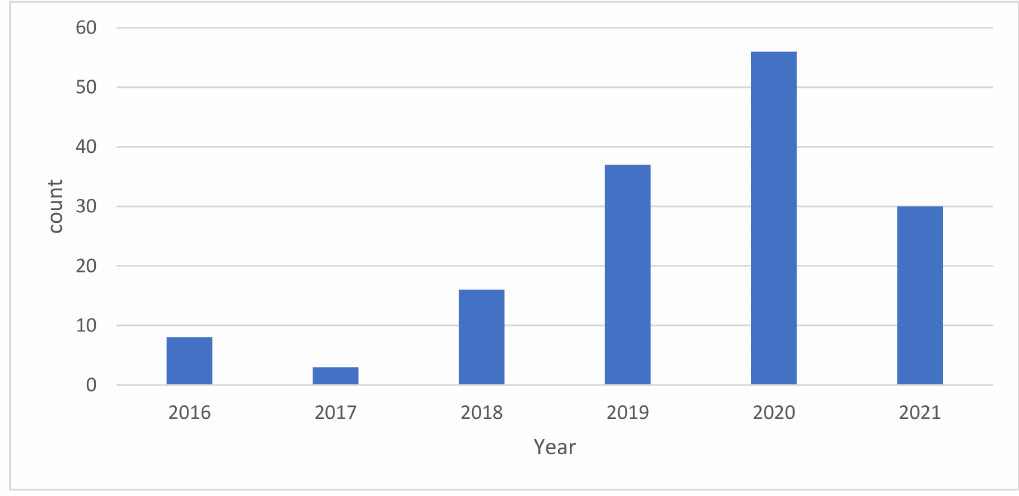
Figure 1. Air pollution publications per year from